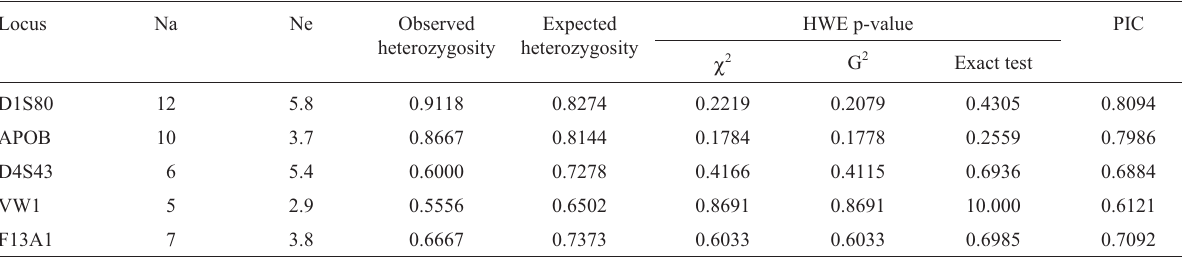
Table 4 - Statistical parameters for autosomal loci in the Curiau population. Locus